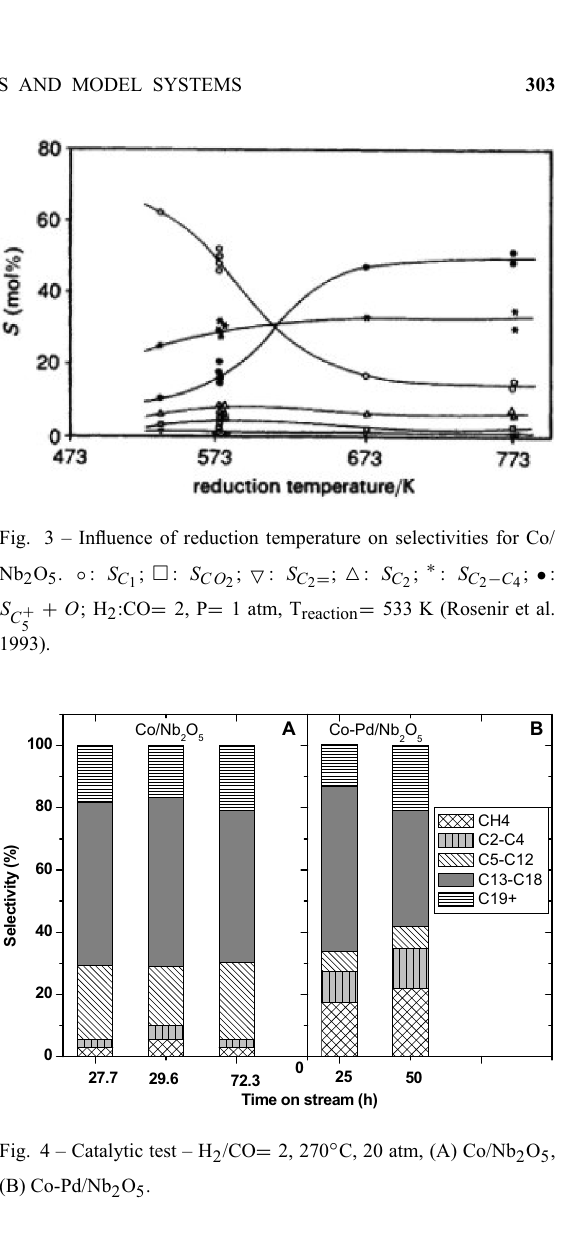
Fig. 4 – Catalytic test – H 2 /CO = 2, 270 ◦ C, 20 atm, (A) Co/Nb 2 O 5 , (B) Co-Pd/Nb 2 O 5 .